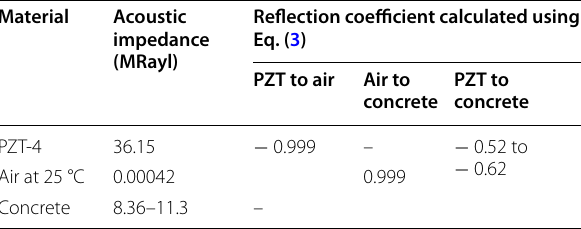
*A negative reflection coefficient represents the phase inversion of the wave